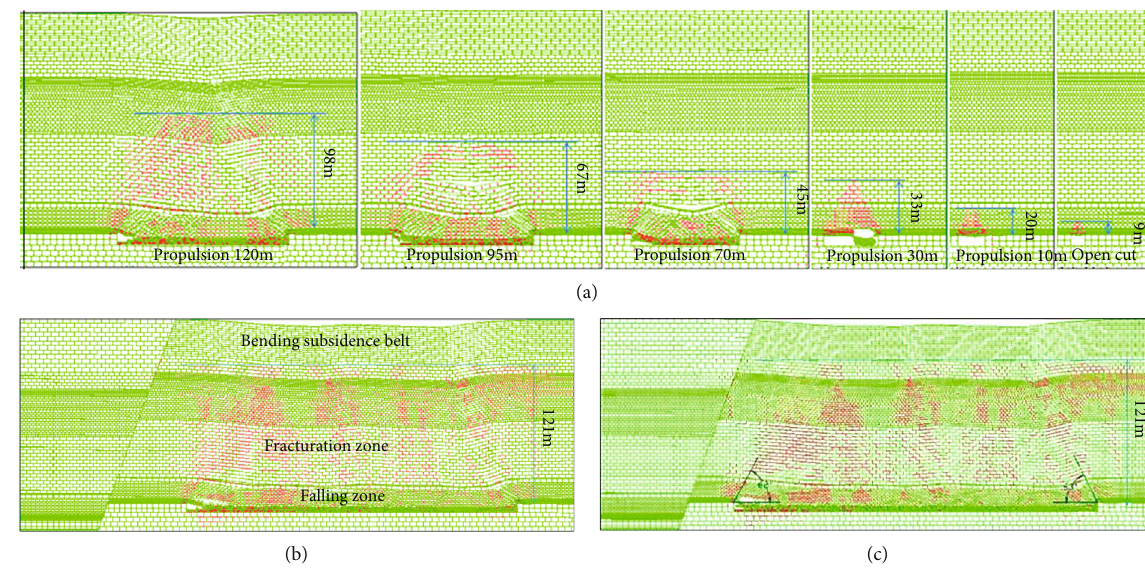
Figure 6: Variation of height of water fl owing fractured zone with advancing distance of working face, including (a) 0, 10, 30, 70, 95, and 120m and (b) 300 m and (c) stop mining